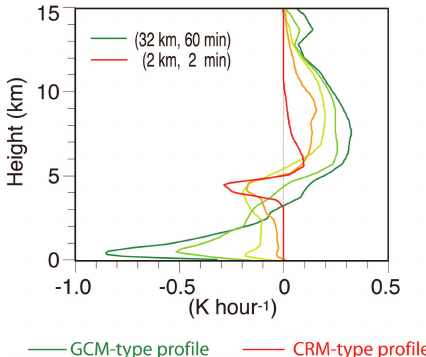
Fig. 4. Ensemble averages of the “required” source of moist static energy obtained through budget analyses of CRM-simulated data for various space/time intervals. Redrawn from Jung and Arakawa